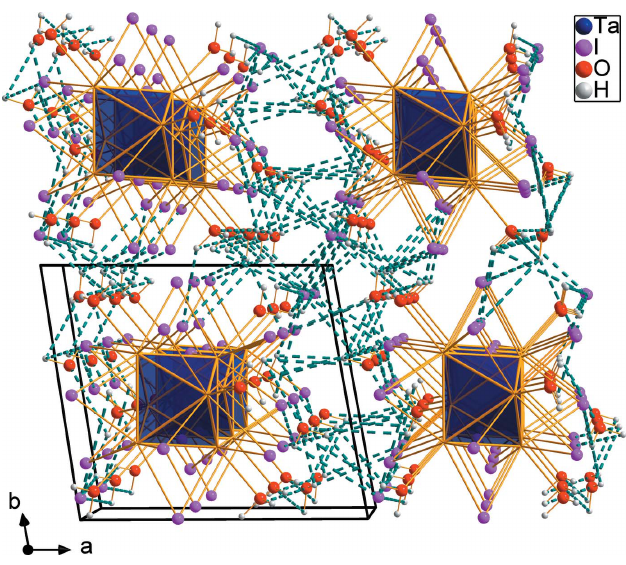
Figure 2 Packing of cluster units, iodide anions, and co-crystallized water molecules of [Ta 6 I 12 (H 2 O) 6 ]I 2 (cid:2) 4H 2 O in a view along the c axis with O— H (cid:2)(cid:2)(cid:2) O and O—H (cid:2)(cid:2)(cid:2) I hydrogen bonds shown as blue–green dashed lines.